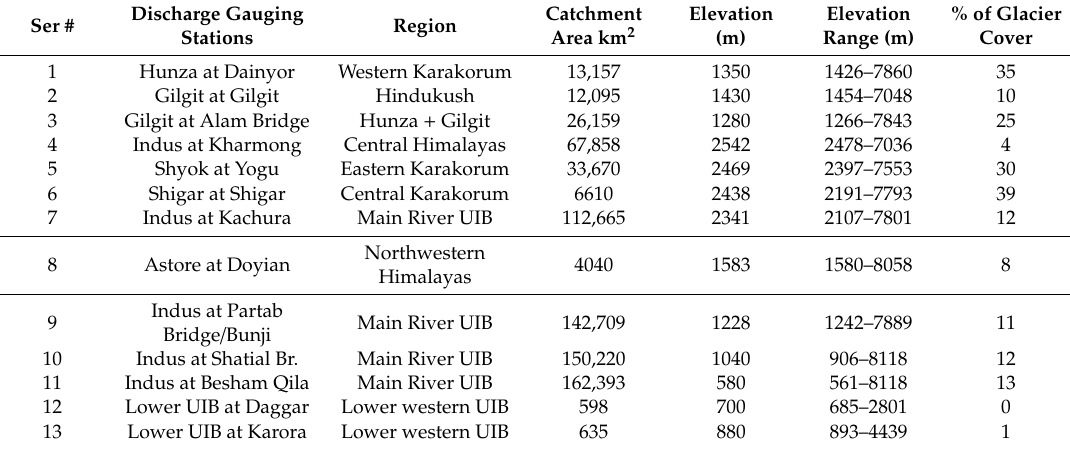
Table 1. Geographical characteristics of the stream gauging sites measuring flows and suspended sediment concentrations (SSC) in the Upper Indus Basin